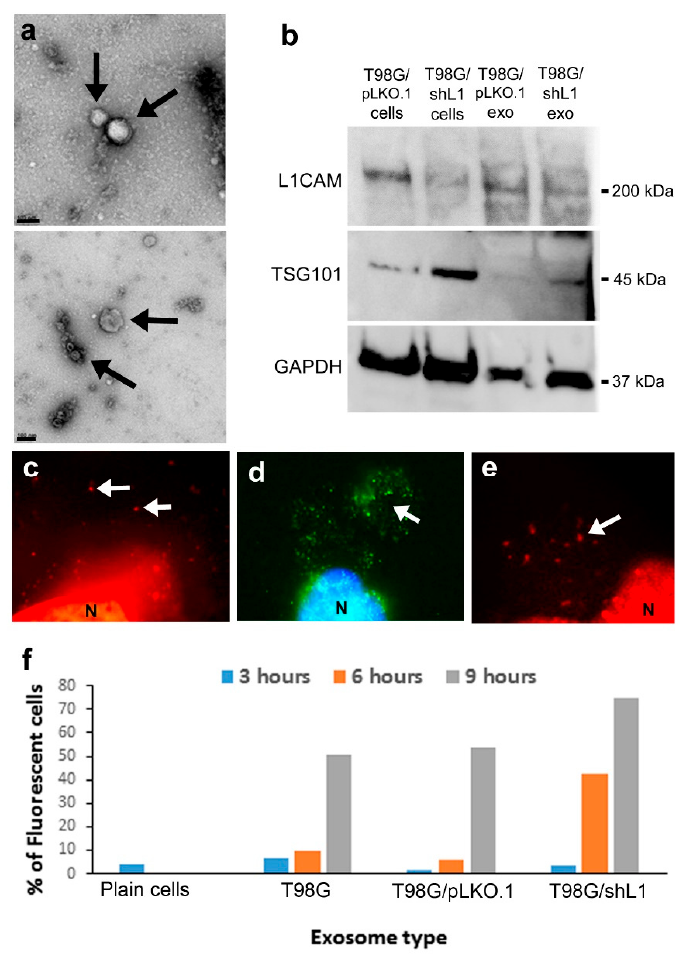
Figure 1. Exosome characterization and binding. ( a ) Electron micrographs of exosomes (arrows) isolated by ultracentrifugation. Scale bars = 100 nm. ( b ) Western blot analysis of cells and isolated exosome preparations. Blot was stained for L1 and then stripped and stained for TSG101 and GAPDH. ( c ) Visualization of FM 4-64 stained fluorescent exosomes binding to live cells. They appeared as small red puncta (arrows), N nucleus. ( d ) Exosomes stained with fluorescent Vybrant DiO resulted in bright green puncta (arrow) on cell surfaces, N blue nucleus stained with bisbenzimide. ( e ) Exosomes bound to cells stained for L1 with UJ127 antibody and red secondary (arrow), N nucleus. ( f ) DiO stained exosome uptake by T98G/shL1 cells over time. The exosomes were incubated with the cells for 3, 6, or 9 h. Cells then were analyzed for fluorescence intensity using flow cytometry. Cells showed increased fluorescence over time, and thus uptake of exosomes, by 6 or 9 h. The plain cell sample was the initial fluorescence of the cells with no exosomes added. Data in (f) are from one uptake experiment.